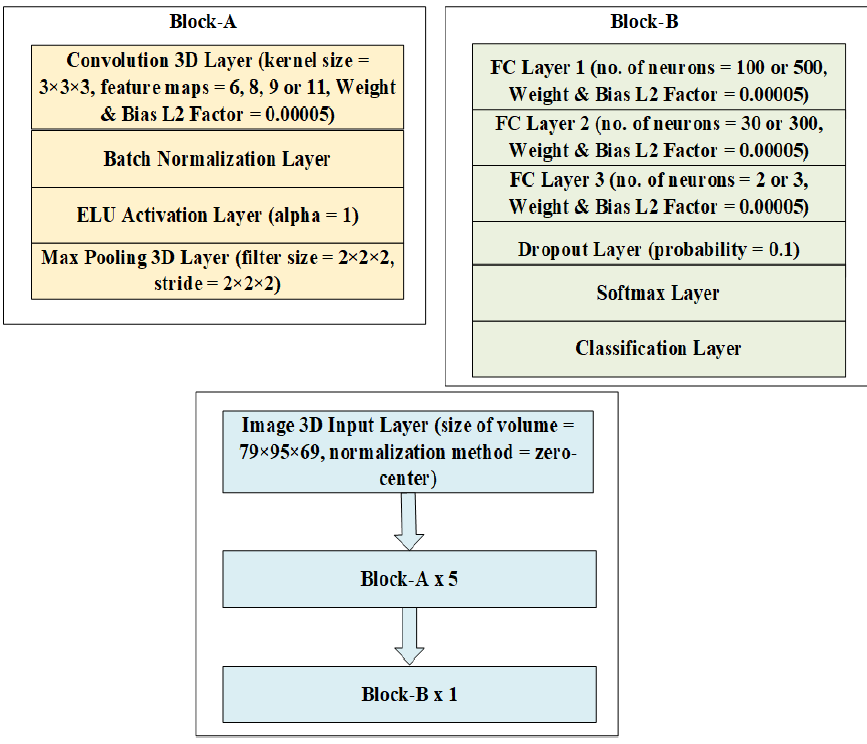
Figure 1. Three-dimensional (3D)-CNN architecture for processing PET scans for binary and multiclass classification tasks.